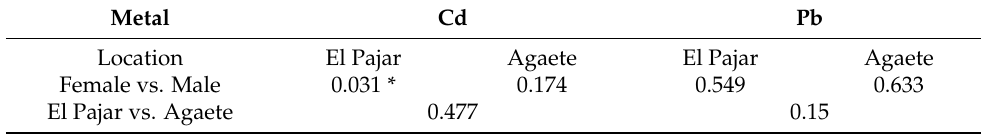
Table 3. PERMANOVA analysis of heavy metals in muscle tissue with the location and sex